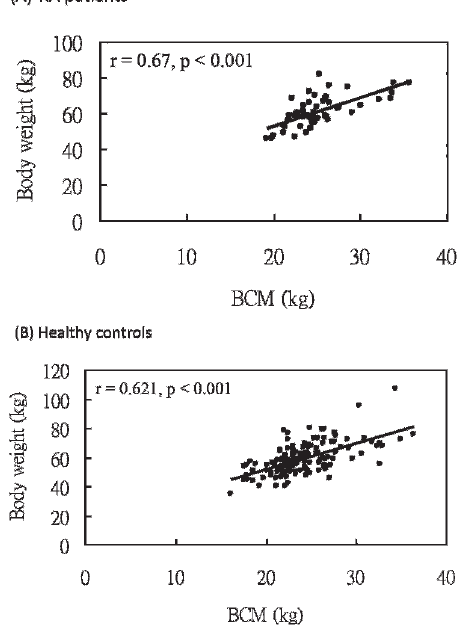
Figure 1 - Linear correlation between body cell mass (BCM) and body weight in (A) 149 RA patients (correlation coeffi- cient=0.62, p , 0.001) and (B) 53 healthy control subjects, (correlation coefficient =0.67, p , 0.001) as determined